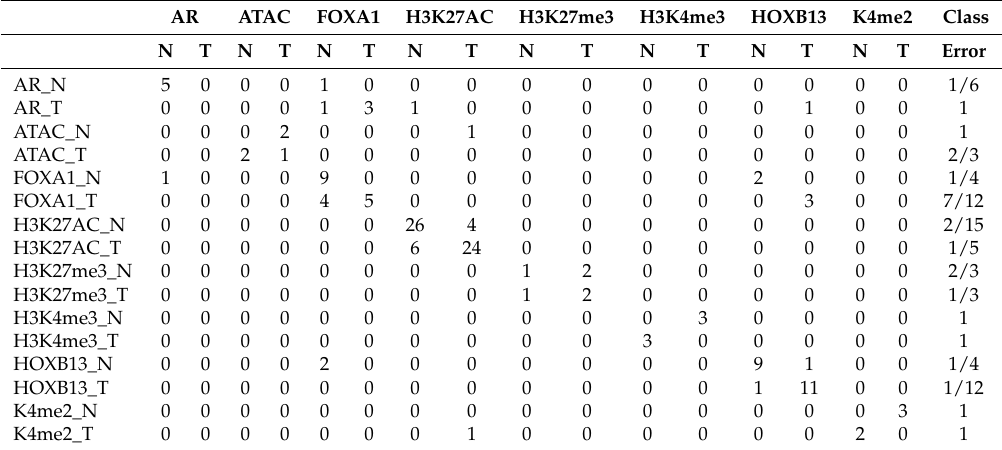
Table 7. Confusion matrix for RF applied to the real dataset. N: normal prostate, T: tumor. The error rate is 35%.